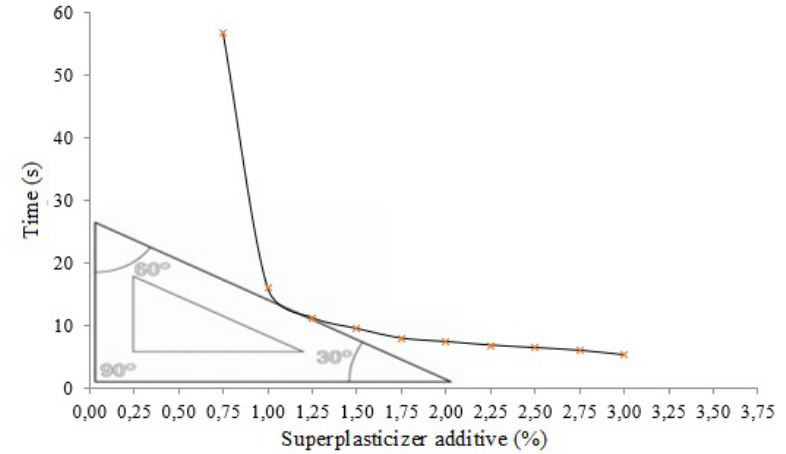
Figure 3. Graphic det ermination of the PCE saturation point for w/c ratio of 0.23.